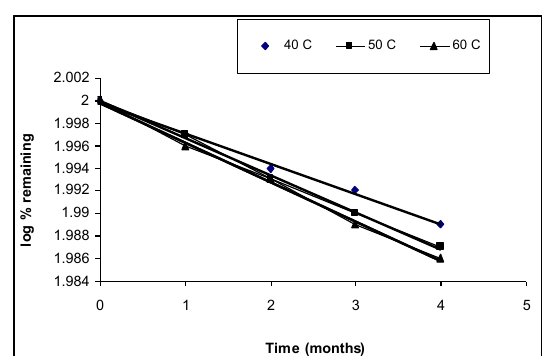
Figure (2): Degradation curve of frusemide syrup (formula II) at 40, 50, 60 0 C 1.9551.961.9651.971.9751.981.9851.991.99522.005